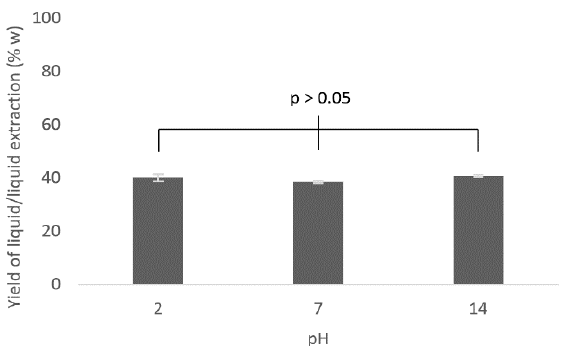
Figure 14. Influence of the pH on the yield of liquid/liquid extraction of aqueous extract (60 mL) treated with ethyl acetate (60 mL) at room temperature. All the values are not significantly different ( p < 0.05) according to the Student test ( t- test).